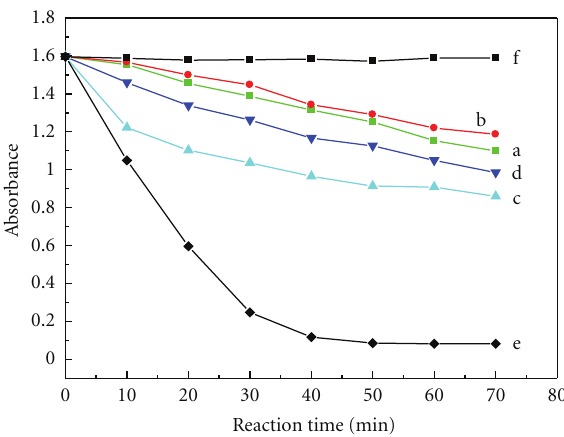
Figure 5: Photodegradation curves of methylene blue using di ff er- ent samples (a) P25; (b) TiO 2 ; (c) AgBr; (d) AgBr/P25 ( m AgNO m = 3 . 35); (e) AgBr/TiO TiO 2